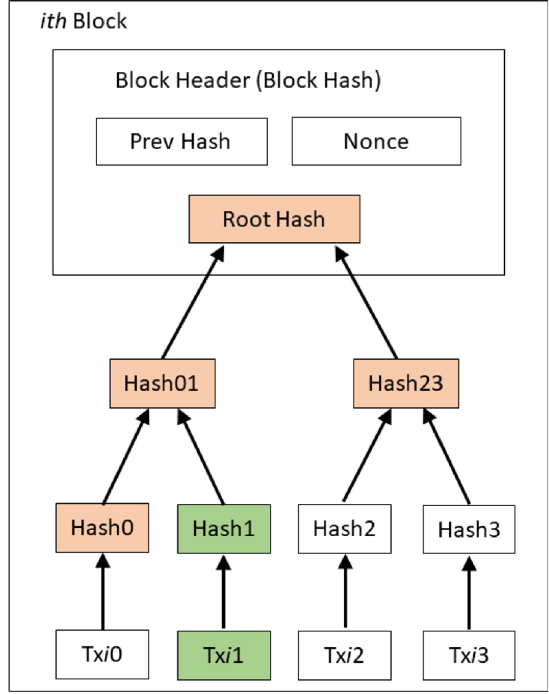
Figure 7. Binary Merkle tree (BMT) on a blockchain